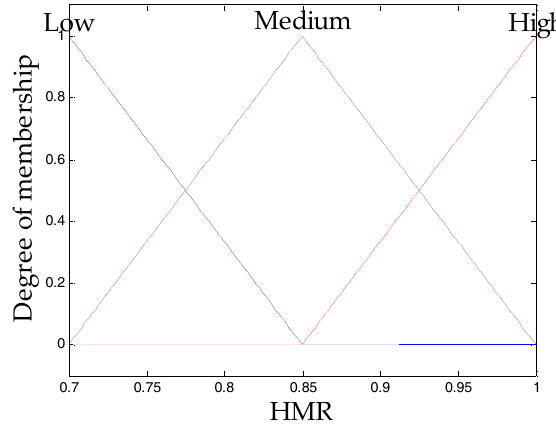
Figure 3. Output of Fuzzy System 1: HMR (Harmony Memory Accepting Parameter).